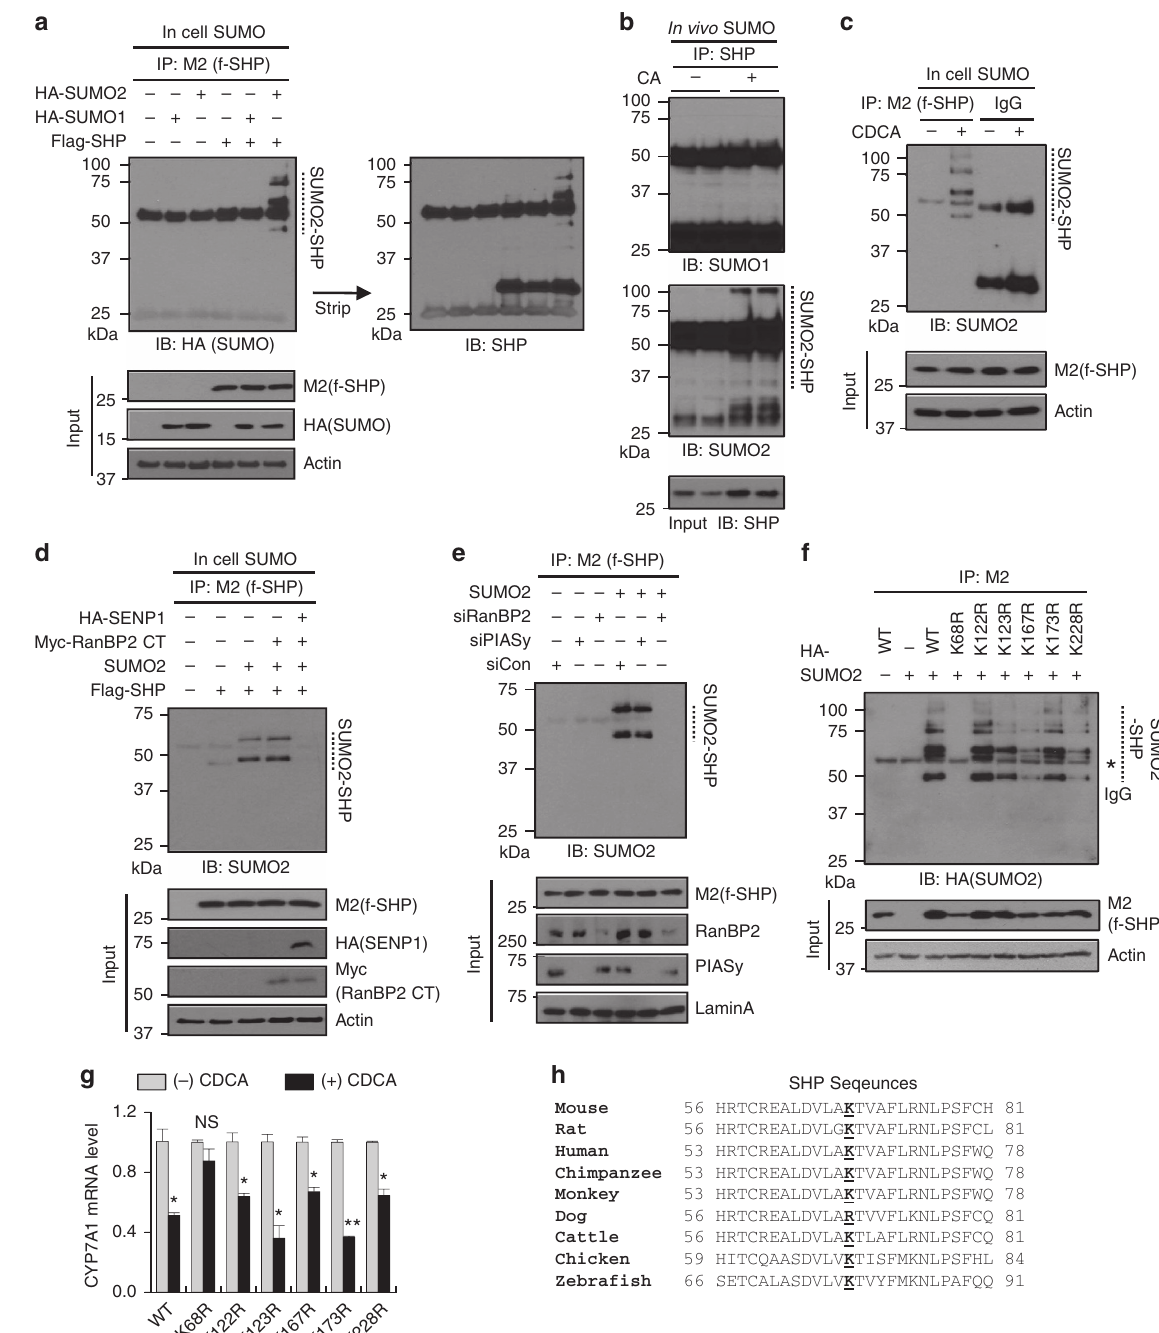
Figure 2 | SHP is SUMOylated at K68 by RanBP2. ( a , c – f ) HepG2 cells were transfected with expression plasmids or siRNA as indicated. Cells were treated with CDCA for 15min, flag-SHP was immunoprecipitated and SUMOylated SHP in the immunoprecipitates was detected by IB with SUMO or HA antibody. Input levels of the proteins were detected by IB as indicated. ( b ) In vivo SUMO assay: SUMO1- or SUMO2-levels of endogenous SHP in livers of mice fed normal or CA chow for 3h were detected by IP/IB. ( e ) Flag-SHP WT and mutants with Lys to Arg mutations were expressed with SUMO2 in HepG2 cells. The flag-tagged proteins were immunoprecipitated and SUMOylated SHP was detected by IB with HA antibody. ( g ) Flag-SHP or the indicated mutants were expressed in HepG2 cells that were treated with vehicle or 50 m M CDCA for 6h, and levels of CYP7A1 mRNA were determined. The control samples are set to 1 for each SHP protein. Values represent mean ± s.e.m. Statistical significance was determined by the Student’s t -test, ( n ¼ 3, * P o 0.05, ** P o 0.005 and NS, statistically not significant). ( h ) Comparison of amino acid sequences adjacent with K68 in the indicated vertebrate species. signalling 11 , we examined potential cross-talk between the downregulation of PKC qz abolished SUMOylation of SHP phosphorylation and SUMOylation of SHP. The BA-induced (Fig. 5c), while downregulation of RanBP2 did not affect RanBP2 interaction with SHP was completely abolished in the phosphorylation of SHP at Thr-58 (Fig. 5d). These results phosphorylation-defective T58A mutant (Fig. 5a). Further, the suggest that phosphorylation of SHP by PKC z is upstream of T58A SHP mutant was not SUMOylated (Fig. 5b) and RanBP2-mediated SUMOylation. NATURE COMMUNICATIONS|7:12179|DOI: